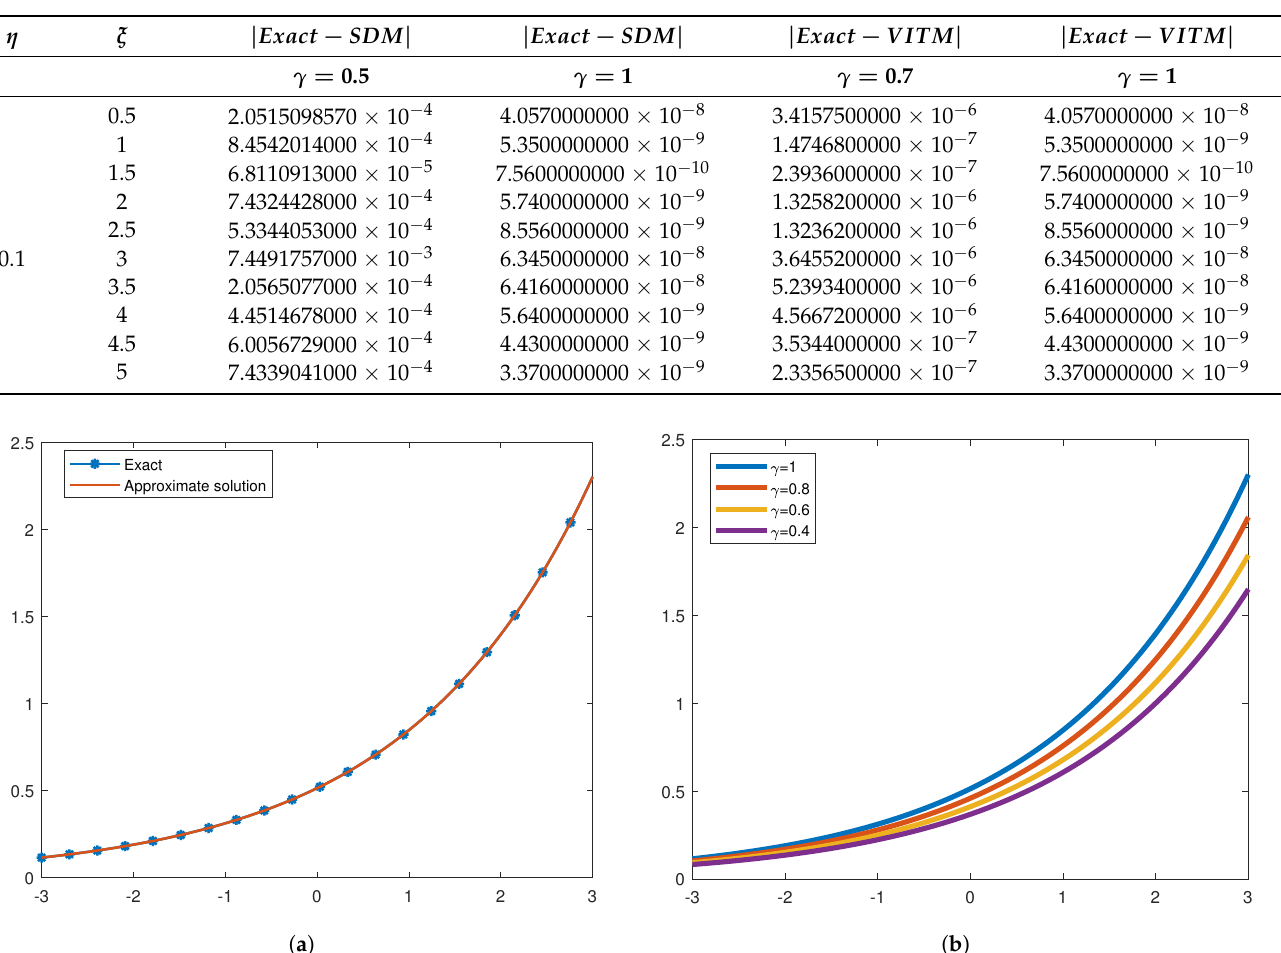
Table 1. The comparison between SDM and VITM for the approximate solution of example 1.